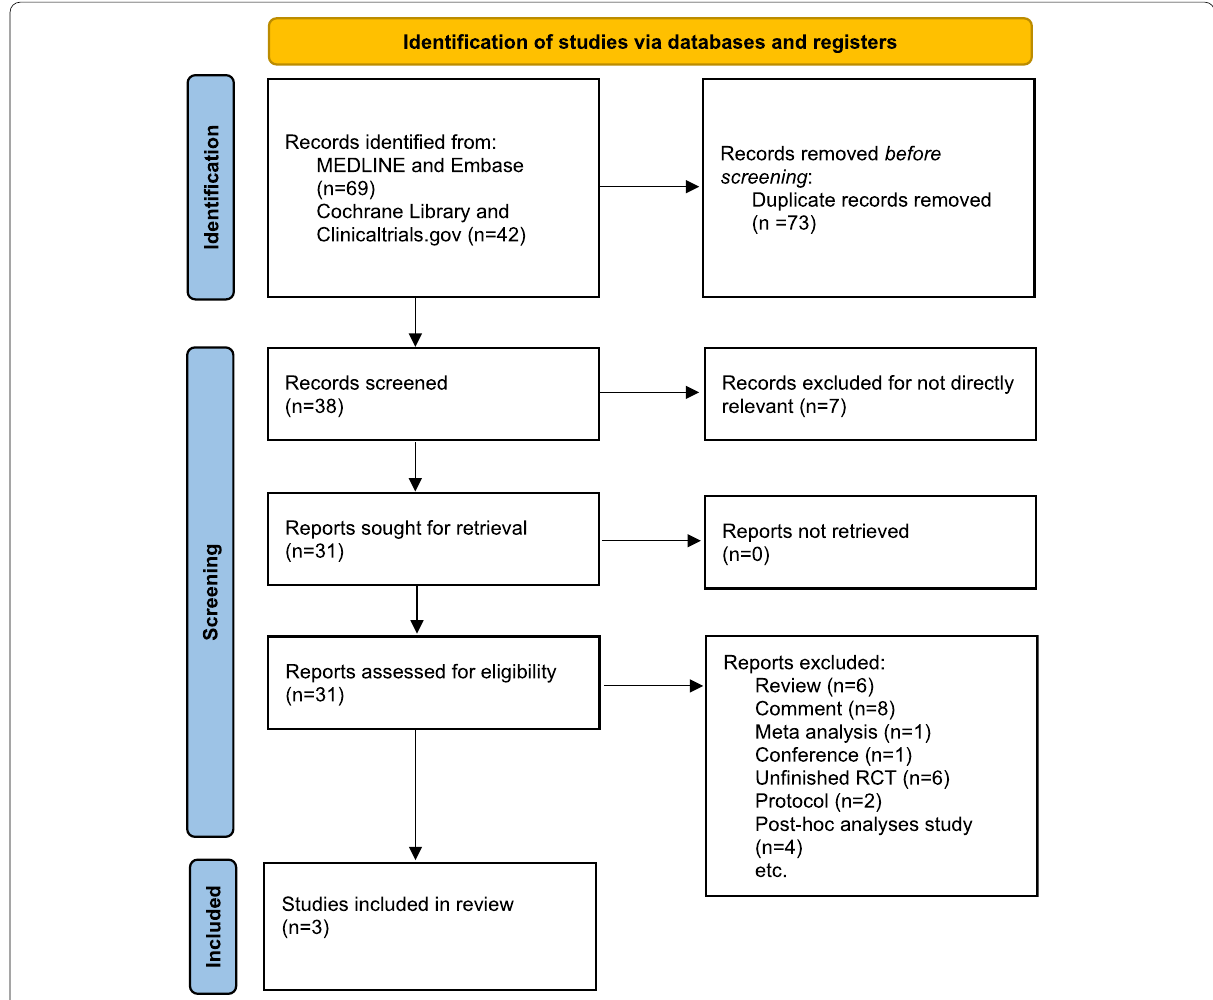
Fig. 1 The study search, selection and inclusion